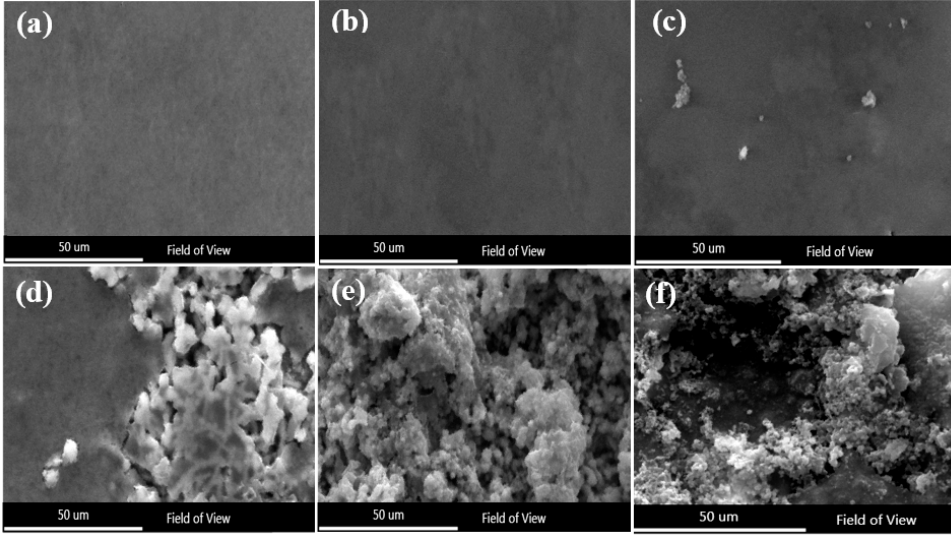
Figure 6. SEM images of pitting formed on the samples after test: ( a ) as-sprayed coating, ( b ) 3.5% NaCl, 30 °C, ( c ) 3.5% NaCl, 40 °C, ( d ) 3.5% NaCl, 50 °C, ( e ) 3.5% NaCl, 60 °C, ( f ) 3.5% NaCl, 70 °C. NaCl, 30 ◦ C, ( c ) 3.5% NaCl, 40 ◦ C, ( d ) 3.5% NaCl, 50 ◦ C, ( e ) 3.5% NaCl, 60 ◦ C, ( f ) 3.5% NaCl, 70 ◦